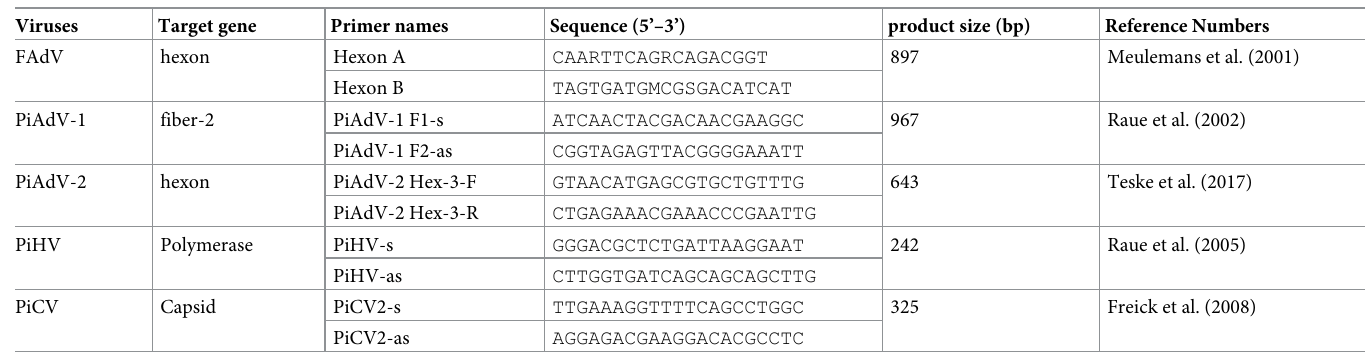
Table 1. Information about the primers used in this